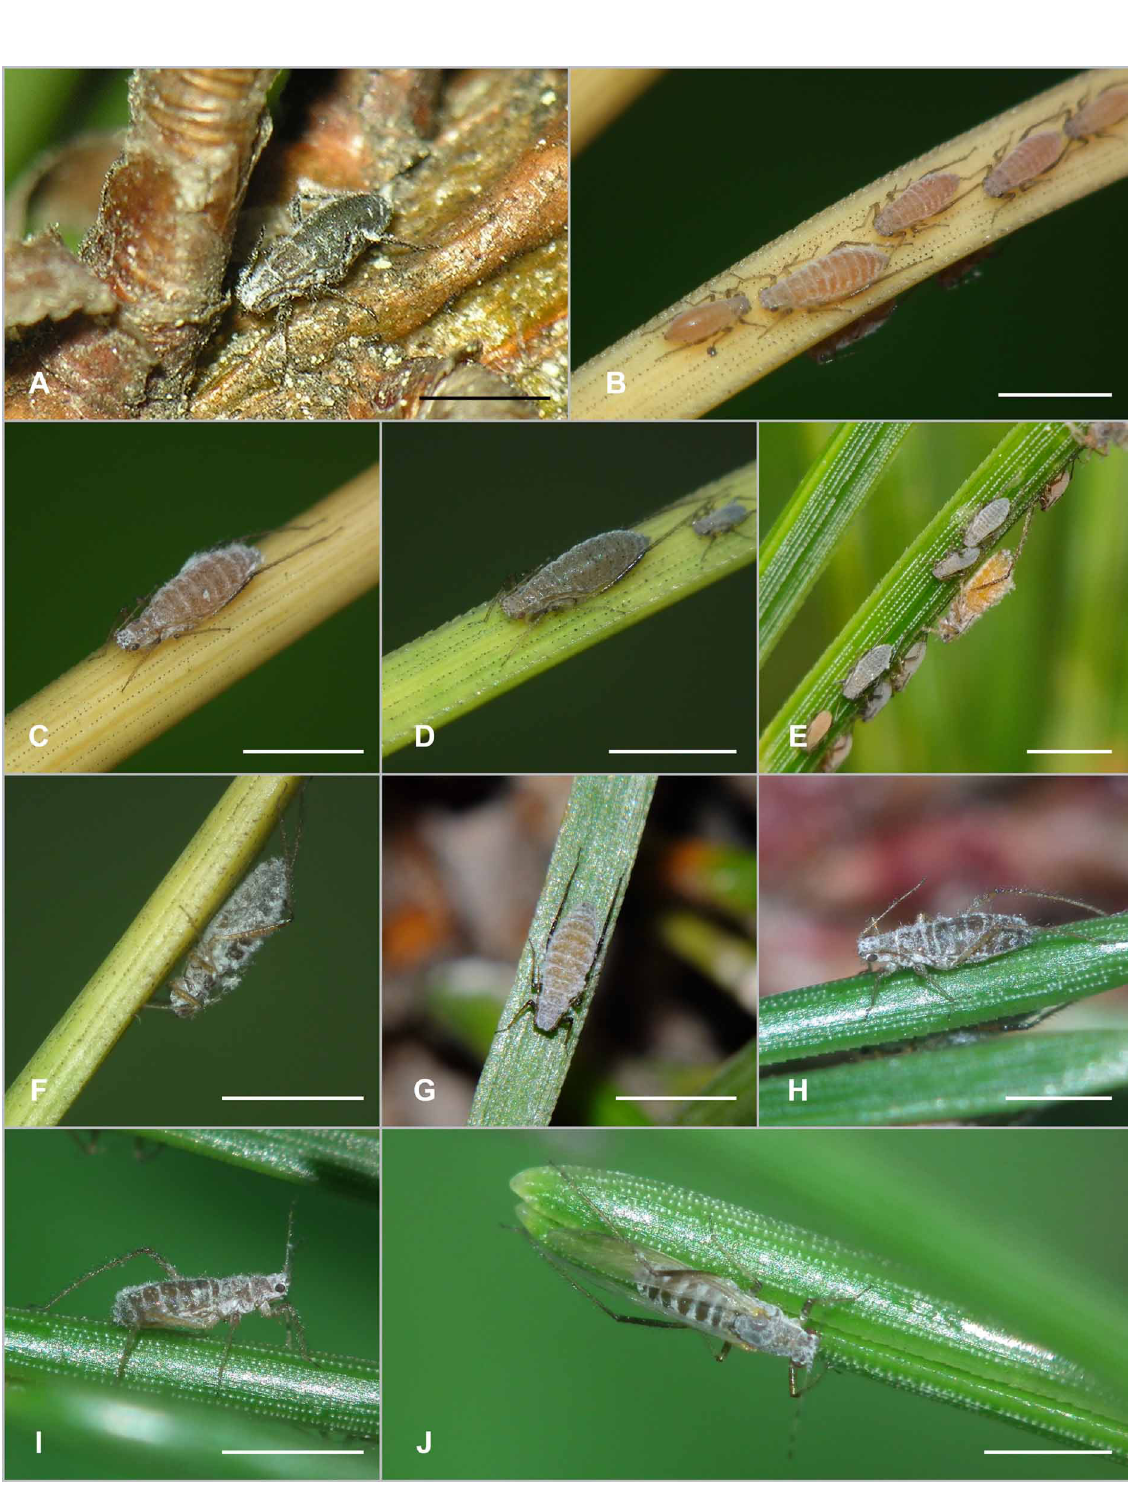
Fig. 83. Eulachnus rileyi (Williams, 1911) on Pinus mugo . Apterae, juveniles, and one alata (J). Scale bars: 2